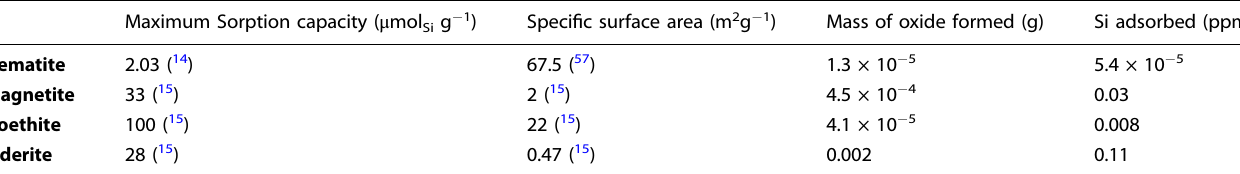
Table 3. Sorption capacities and speci fi c surface areas of oxides of Fe taken from literature. The surface area for SS samples is 9 cm 2 .